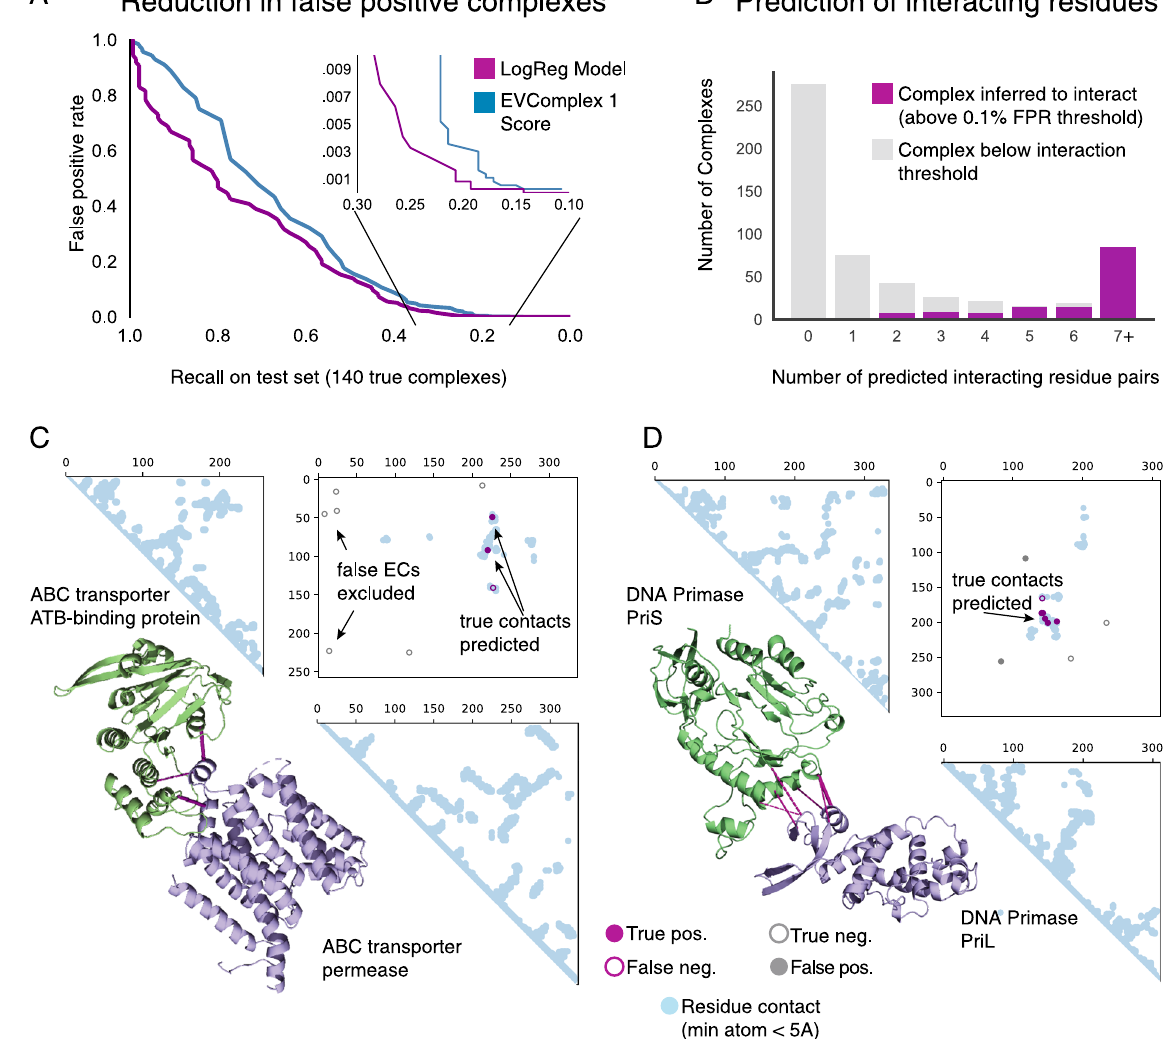
Fig. 2 Model predicts interacting residues and interacting proteins with high precision. A Recall on the held-out fraction of the positive benchmark set (x-axis) and false positive rate on the held-out dataset of non-interacting complexes (y-axis) at a score threshold that gives the corresponding recall. Our logistic regression model (purple) reduces the false positive rate compared to the previous EV Complex score (blue). B Prediction of protein interaction is based on the prediction of interacting residues. Number of predicted interacting residue pairs for complexes inferred to interact (purple) or not inferred to interact (gray) based on our stringent protein complex prediction threshold. C Example performance on known interaction between ABC transporter permease and ATP binding subunit (UniProt IDs: Y1470_HAEIN and Y1471_HAEIN, PDB ID: 2NQ2 chains C and A [https://www.rcsb.org/structure/ 2NQ2]. D Example performance on known interaction between DNA primase PriS and PriL (UniProt IDs: PRIS_SULSO and PRIL_SULSO, PDB ID: 1ZT2